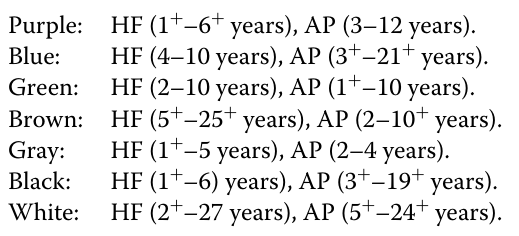
Fig. 6 Green: incidences of green in home furnishings and